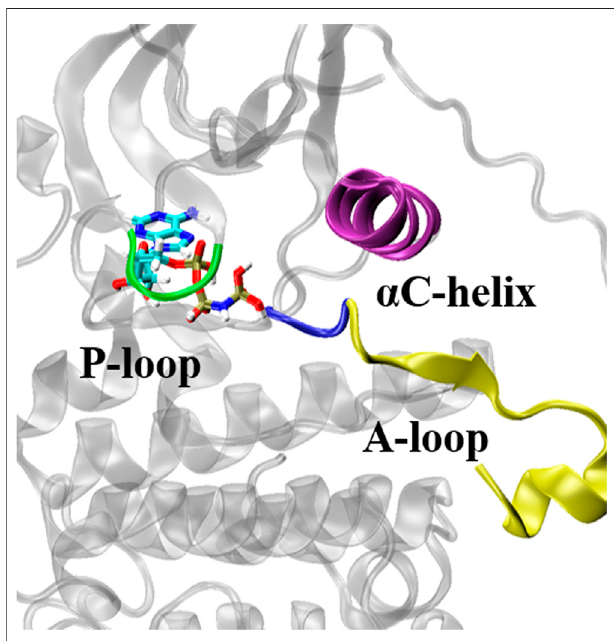
FIGURE 3 | Key structural elements structures of EGFR. The key structural elements are highlighted in purple ( α C helix), yellow (A-loop), blue (the Asp-Phe-Gly motif) and green